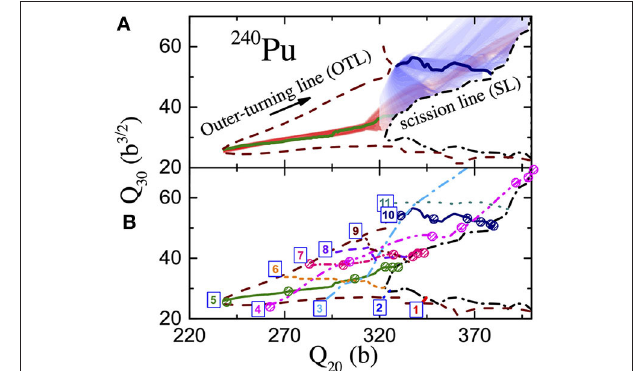
FIGURE 7 | Thick solid lines: projections of the three-dimensional (3D) minimum-action paths for 264 Fm (left) and 240 Pu (right) on the FIGURE 9 | (A) The density of Langevin trajectories for two different initial Q 22 λ 2 ( Q 20 , λ 2 0) (top) and ( Q 20 , Q 22 0) (bottom) planes. Thick dashed configurations and the corresponding EFPs in the ( Q 20 , Q 30 ) plane. The loci of ; = ; = lines: two-dimensional (2D) paths computed without pairing fluctuations. The outer turning-points land scission configurations are shown by dashed and PES corresponding to Q 22 0 (top) and static pairing, i.e., λ 2 0, (bottom) dash-dotted lines, respectively. (B) Eleven EFPs marked according to their = = are shown for reference. The figure is modified from Sadhukhan et al. [ 50]. initial coordinates. The figure is adapted from Sadhukhan et al. [ 92].